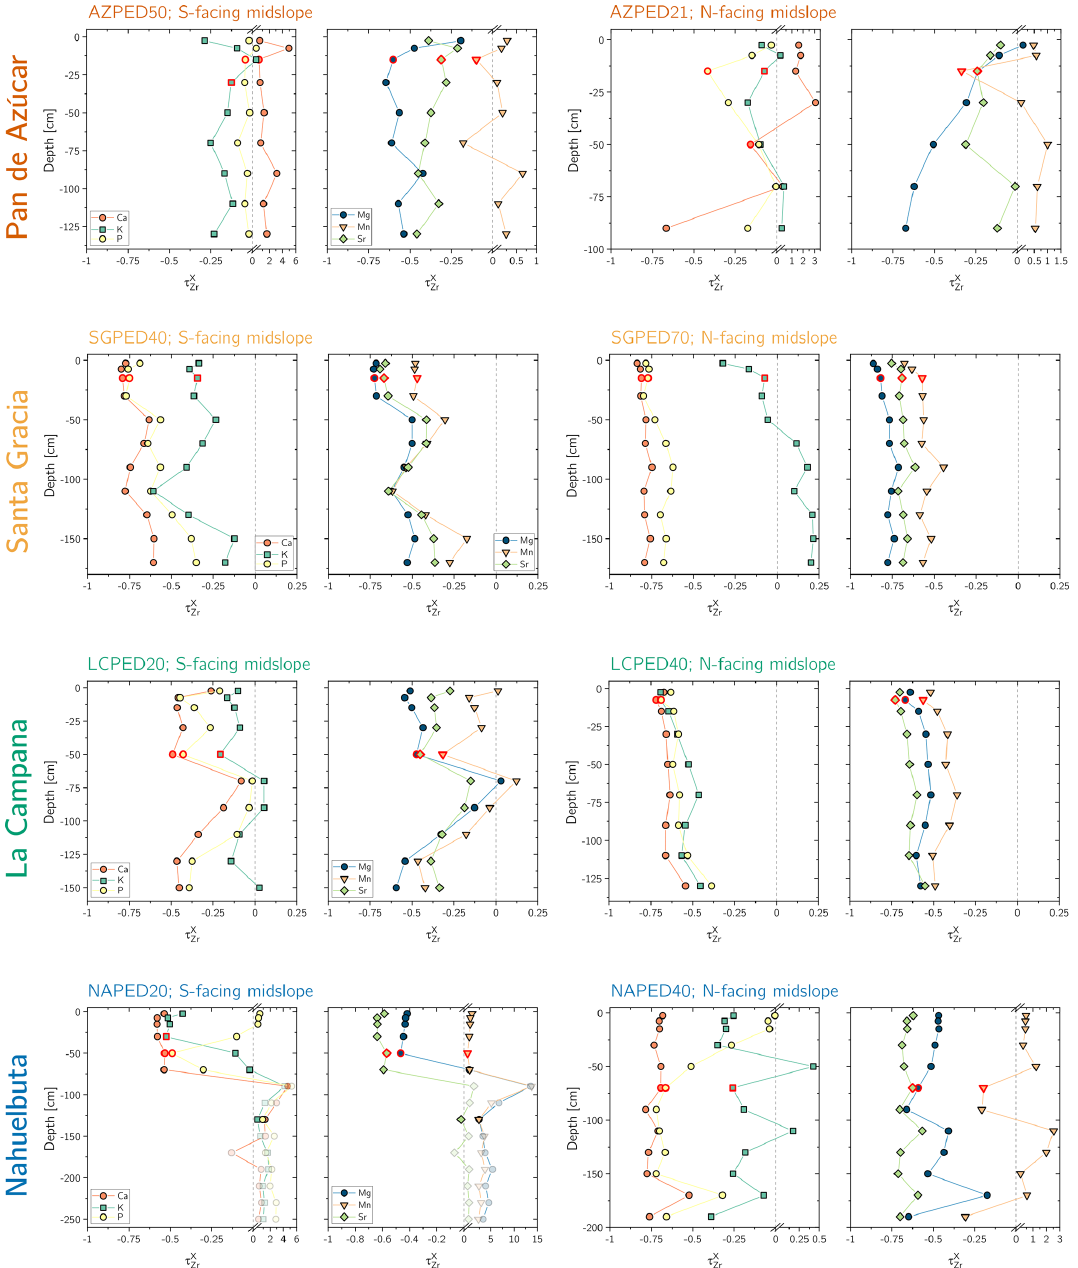
Figure A1. Depth distribution of the elemental loss and gain fractions (i.e., elemental mass transfer coefficient, τ ). The dashed vertical = 0 and represents unweathered parent bedrock. The τ values corresponding to the shallowest mineral soil samples are line indicates τ X Zr highlighted with a red rim. Grey symbols in Nahuelbuta are discarded due to the samples’ anomalous low Zr concentration. Note that these τ values differ from those reported in Oeser et al. (2018) because in this work they have been calculated relative to the initial bedrocks’ chemical